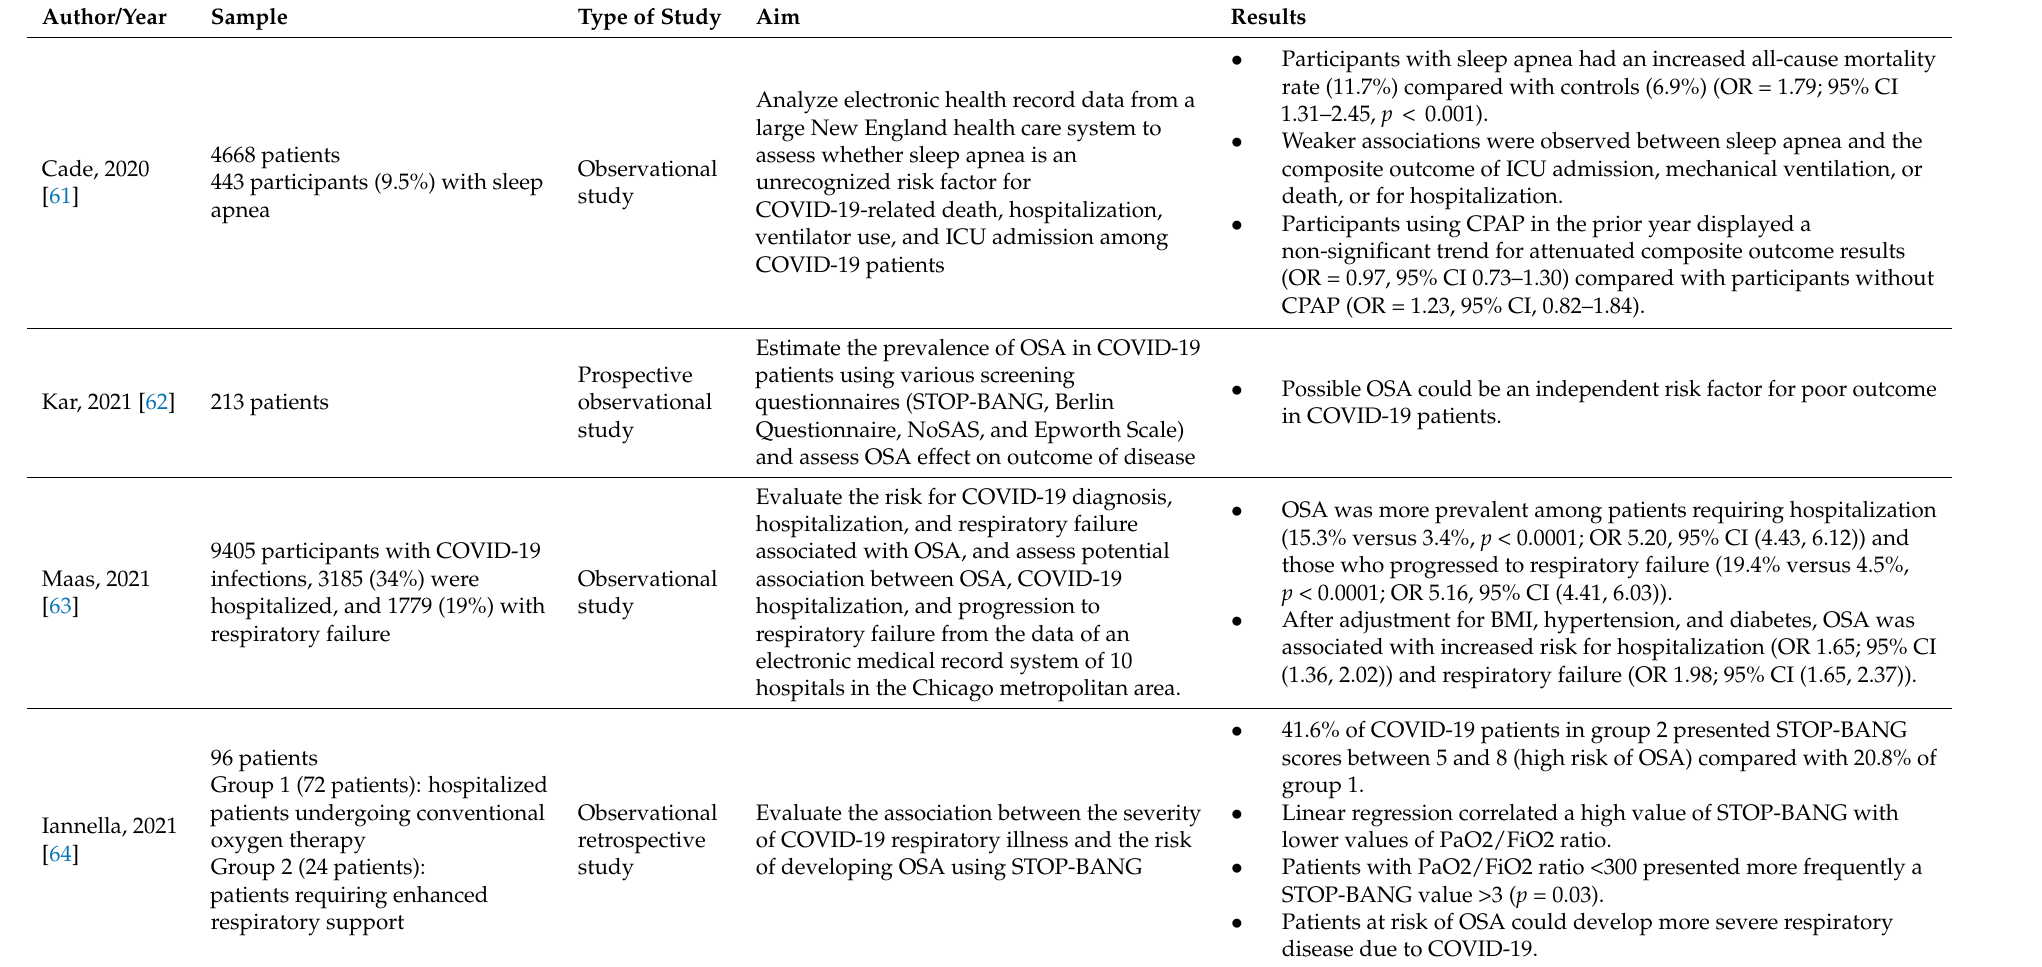
Table 2. Main findings of the studies assessing OSA in COVID-19